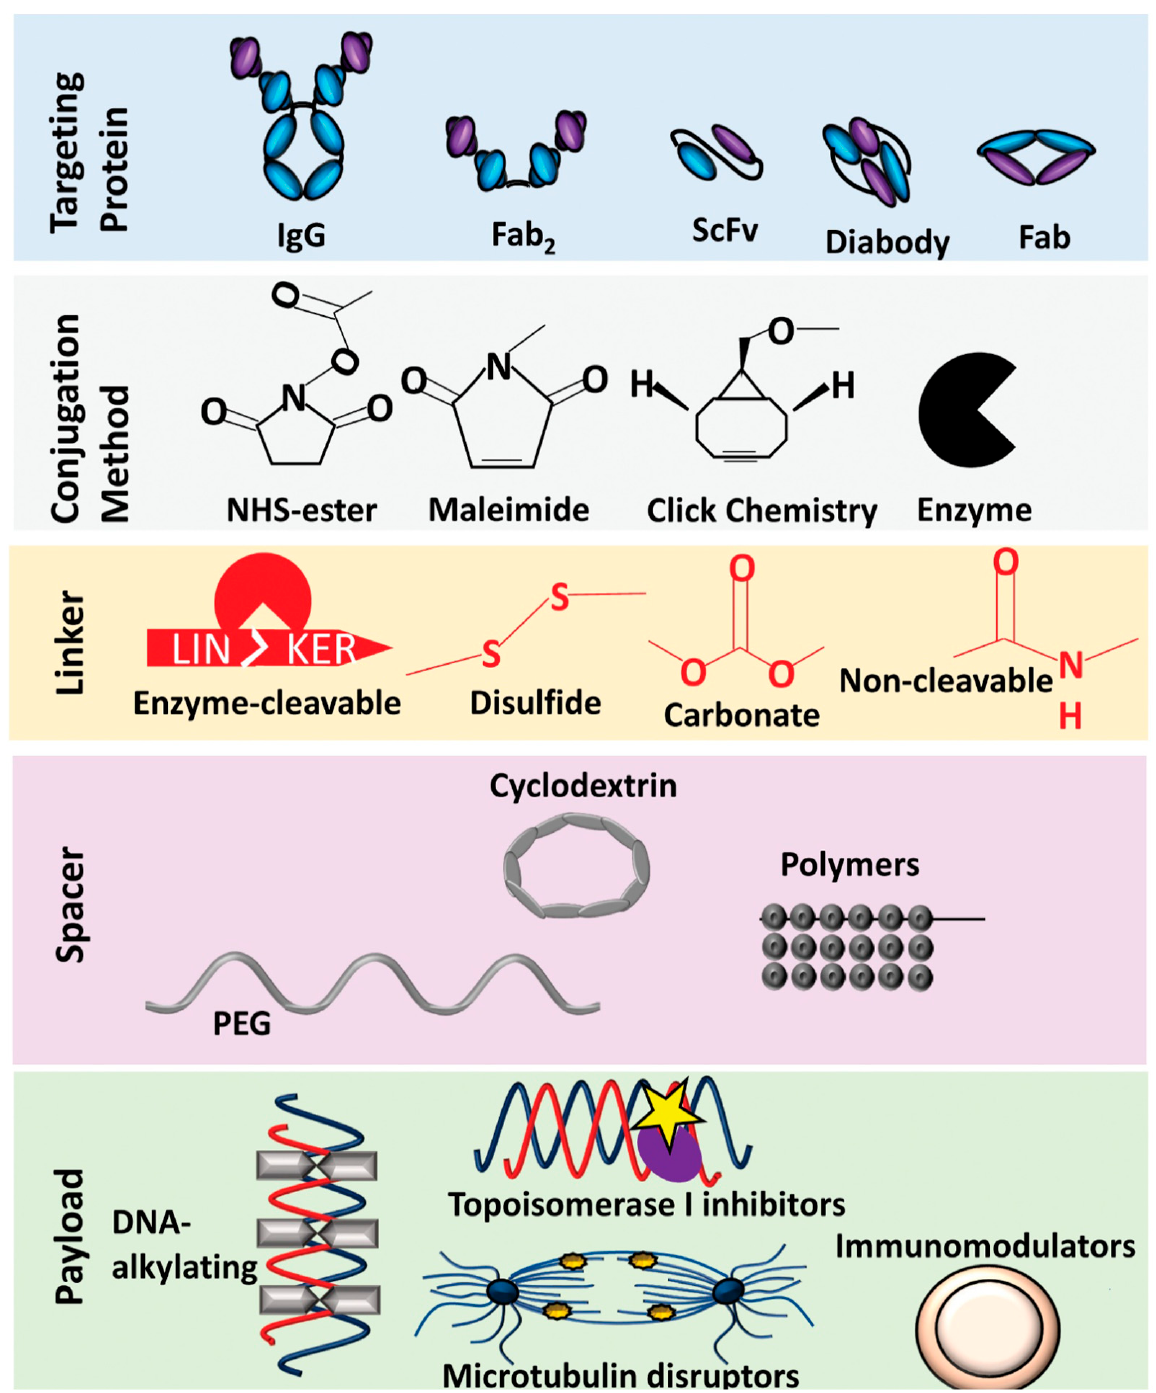
Figure 3. Growing the ADC framework through the utilization of new mAb, conjugation methods, linkers and spacer systems to optimize safety and effectiveness of ADCs for cancer therapy. Adapted from [9].